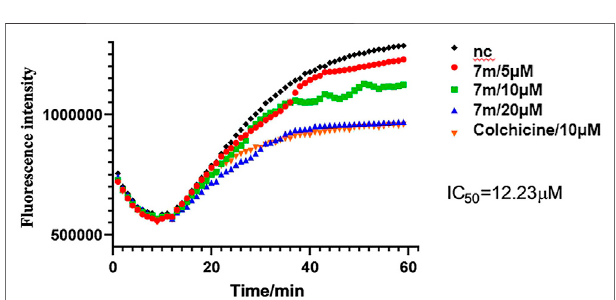
FIGURE 3 | Tubulin polymerization inhibitory activity of 7m in vitro . Polymerization of tubulin at 37 ° C, in the presence of 1% DMSO, compound 7m (5, 10, and 20 µM), and colchicine (10 µM), was measured by monitoring theexcitationat 335 nmandemissionat 460 nm.Dataarepresented as the mean ± SD from three independent experiments. ** p < 0.01 vs. the vehicle